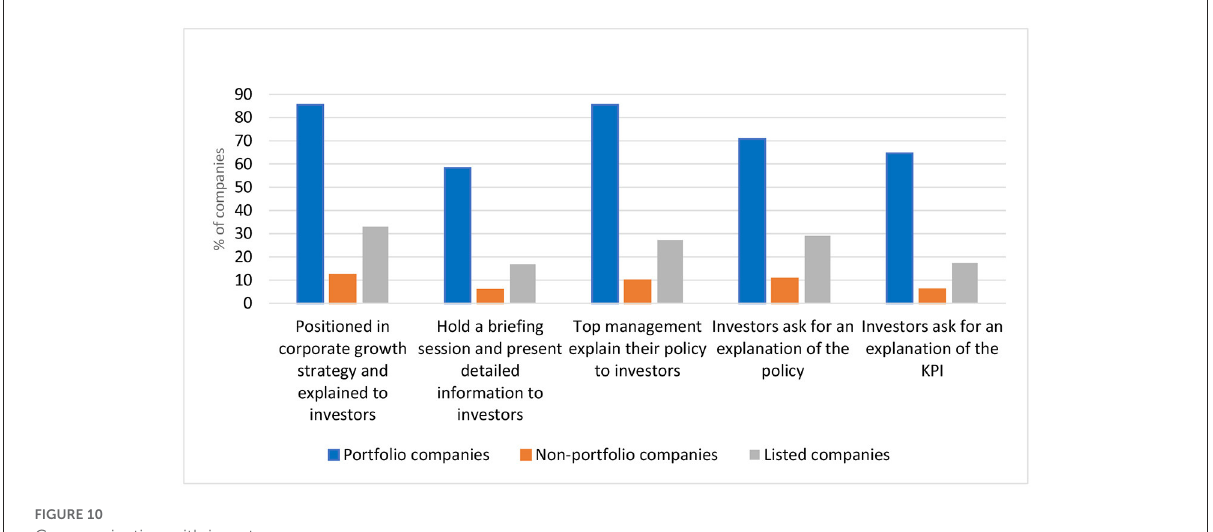
FIGURE10 Communication with investors.